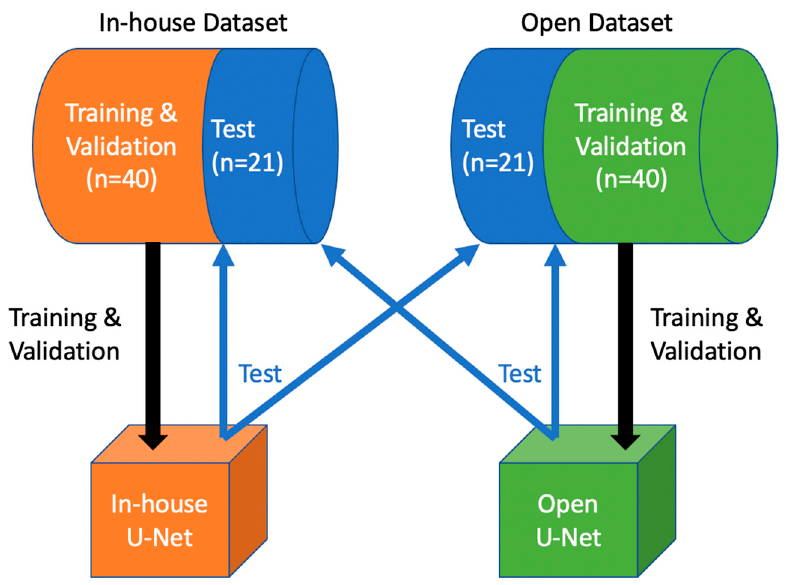
Figure 1. Study Design: In-house U-Net was trained and validated with the in-house training and validation dataset, then tested on both test sets. Open U-Net was trained and validated with the open training and validation dataset, then tested on both test sets.